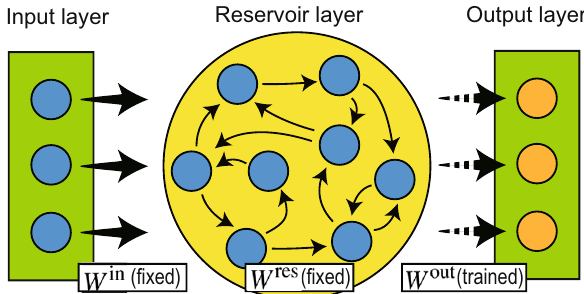
Figure 1. Typical RC architecture. The reservoir layer consists of randomly connected neurons. The connections between the input and reservoir layer W in and connections within the reservoir layer W res are fixed (solid arrows), whereas the output weights W out are trained (dashed